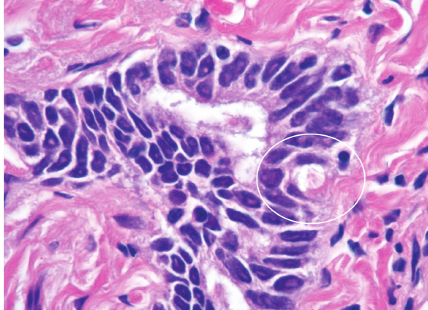
Figure 7: Photomicrograph of endosalpingiotic glandular rest in postneoadjuvant ipsilateral sentinel lymph node capsule with single cell ciliation and eosinophilic terminal bar circled in white (Hema- toxylin and Eosin [H&E] stain, original magnification